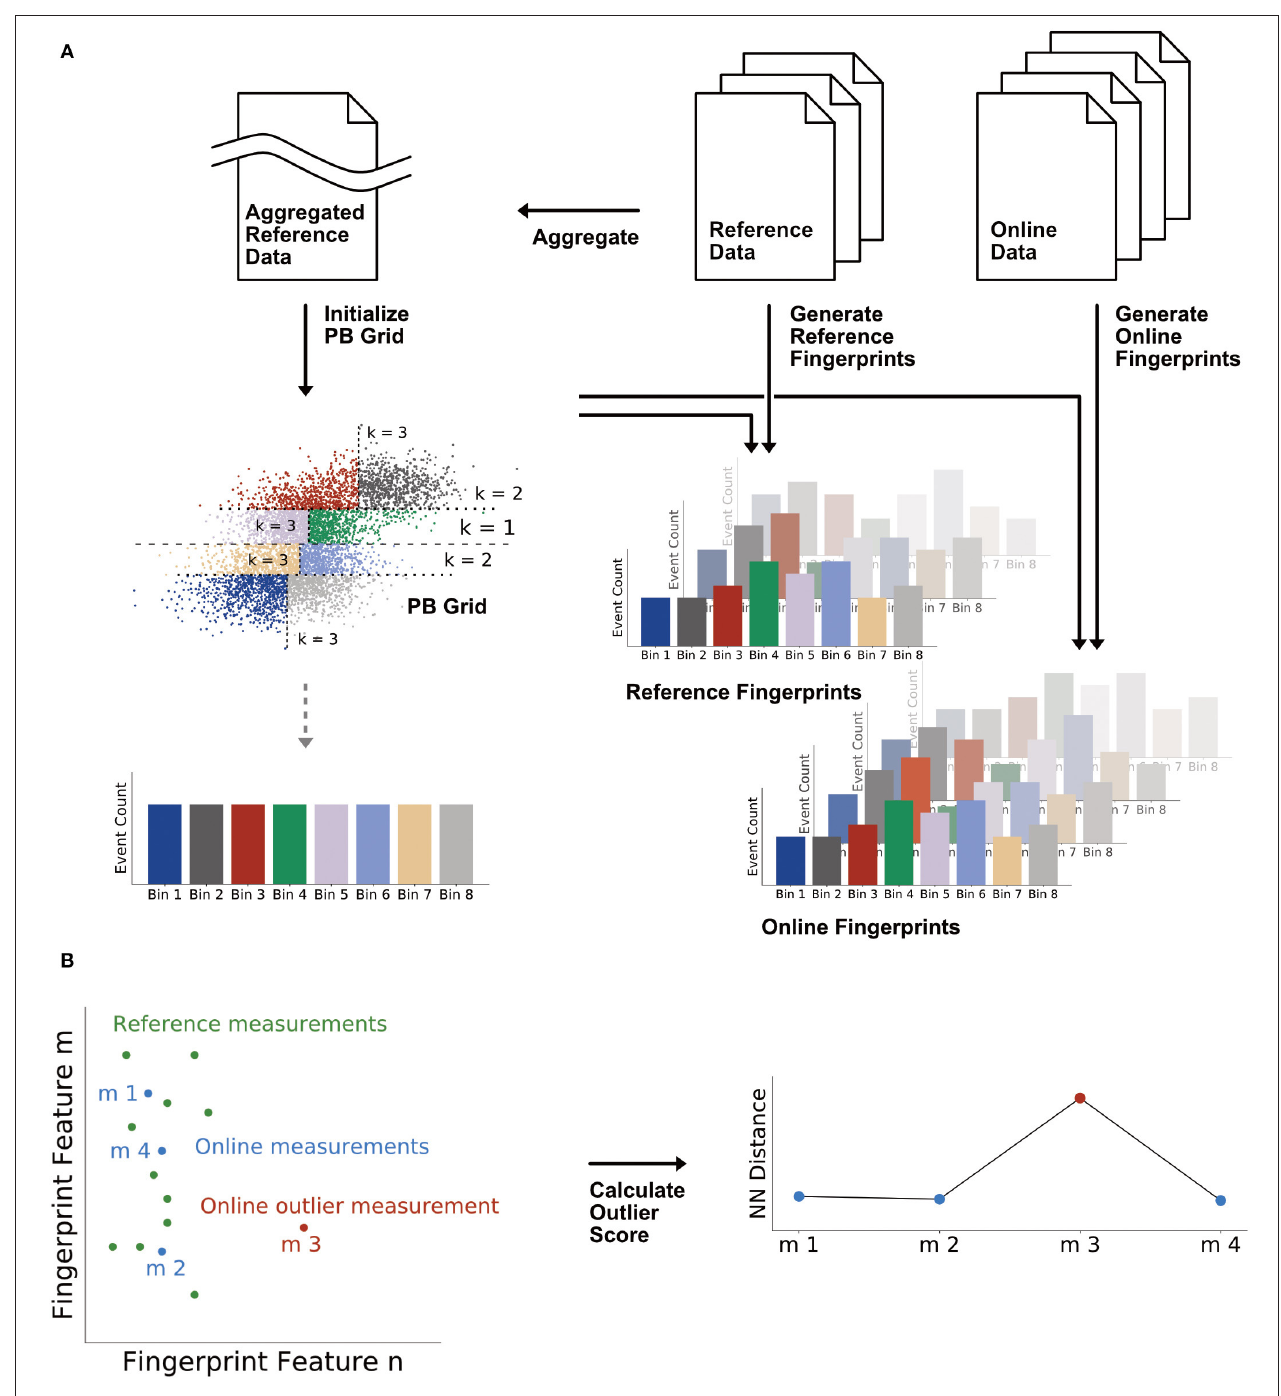
FIGURE 2 | Workflow of the MCCD model which is composed of a fingerprinting algorithm and the k-nearest neighbor algorithm. (A) Fingerprint calculation by the Probability Binning (PB) algorithm. A grid with equal event count is computed on an aggregated data set regrouping all the events from the reference period and is applied to the reference data and to every subsequent online measurement. (B) Distance-based online model where the outlier score is the distance in the fingerprinting space to the nearest neighbor (NN) in the reference set.